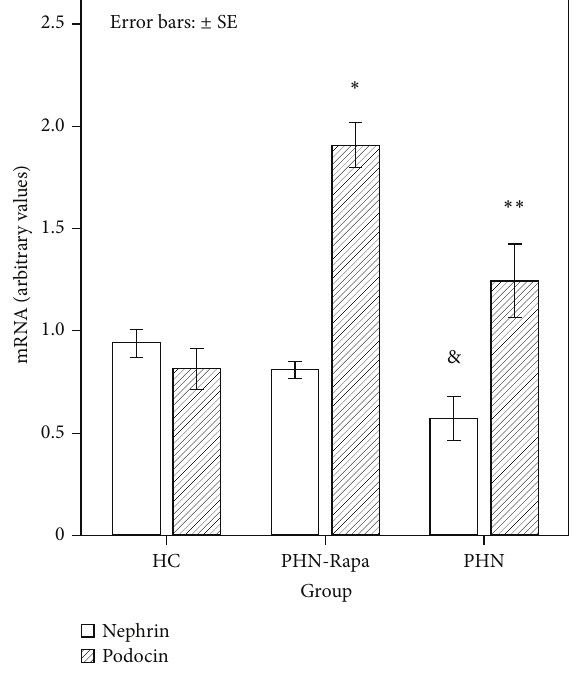
Figure 6: Real time PCR for nephrin and podocin mRNA in glomerular lysates. HC: healthy controls; PHN: Passive Heymann Nephritis; PHN-Rapa: Passive Heymann Nephritis after rapamycin administration. Bars represent nephrin mRNA (white columns) and podocin mRNA (shaded columns) corrected to GAPDH mRNA concentration. ∗ 𝑃 < 0.001 , & 𝑃 = 0.011 , ∗∗ 𝑃 = 0.038 . Error bars: ±